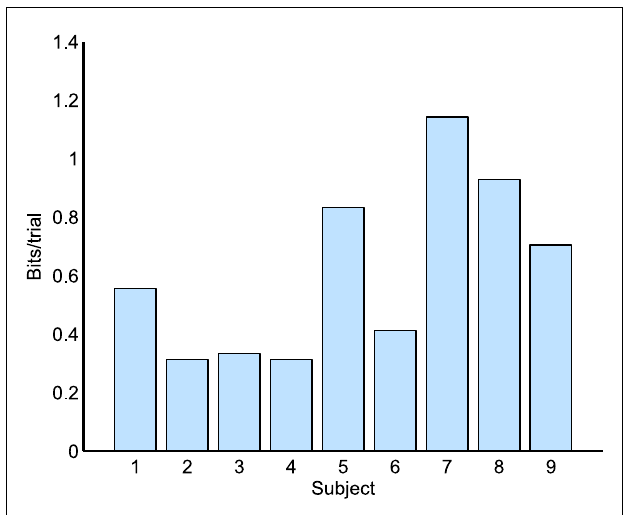
FIGURE 7 | Information transfer rate (ITR) obtained for all nine subjects.